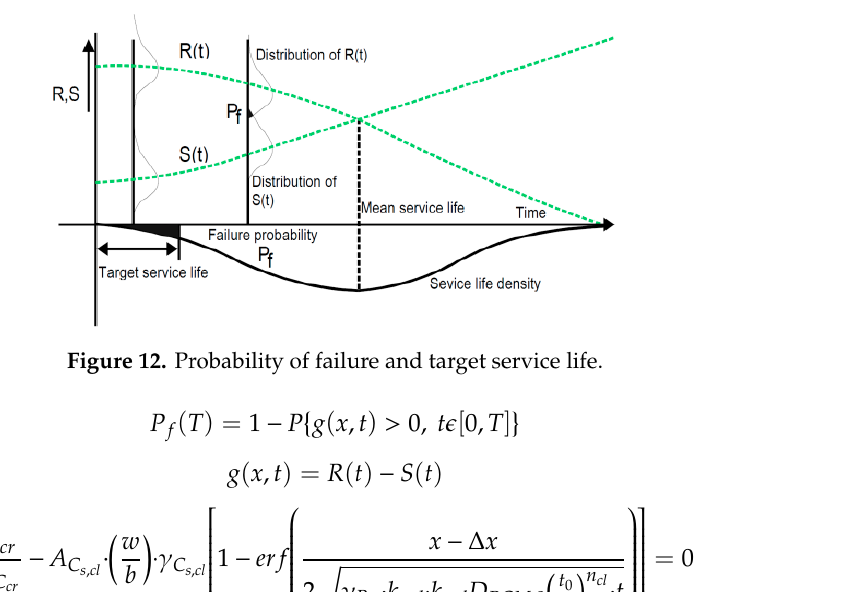
Figure 11. Events during a service life.